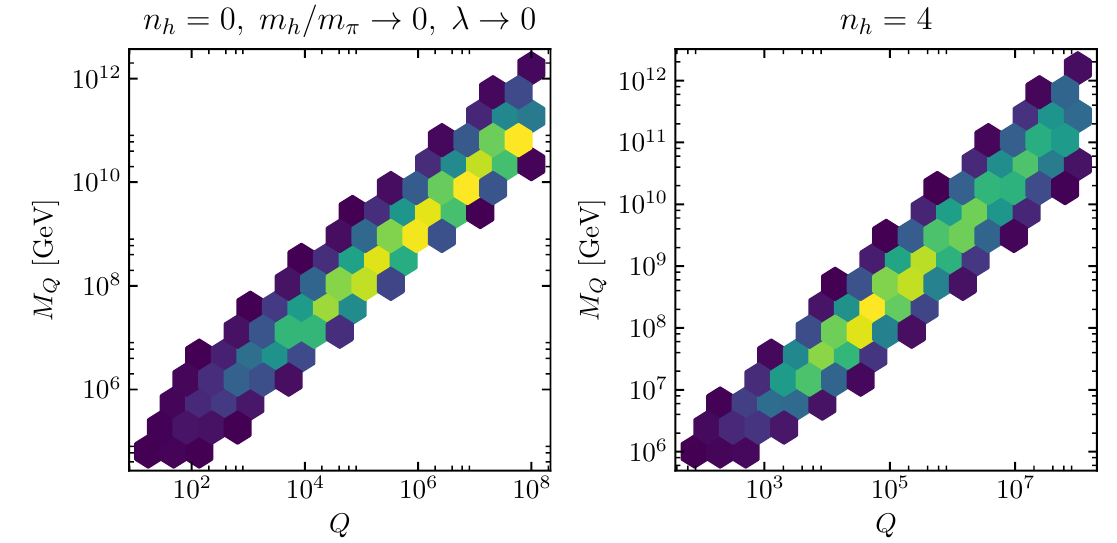
Figure 4 . The distribution of Q-ball solutions in the mass-charge plane. See caption of (cid:12)gure 3 for more details.